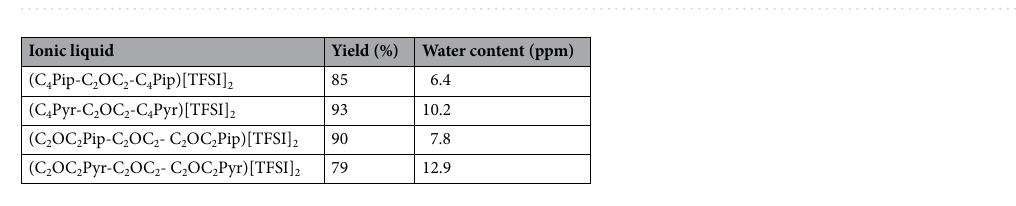
Table 1. Water content and yield of synthesized ionic liquids.